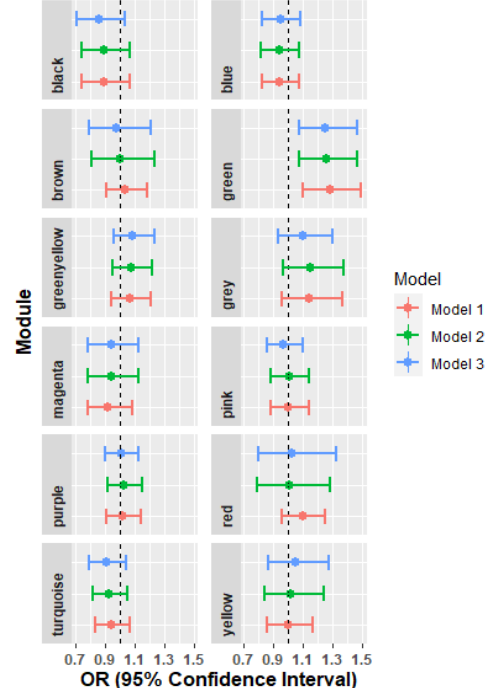
Figure 2. Forest plot representing odds ratio and 95% confidence interval of three models between each module and asthma. Model 1 included age, sex, immigration status, field centers, years of liv- ing in the U.S., and Hispanic and/or Latino backgrounds; Model 2 additionally adjusted for LDL, HDL, and TG; and Model 3 supplemented smoking, education level, and household income.